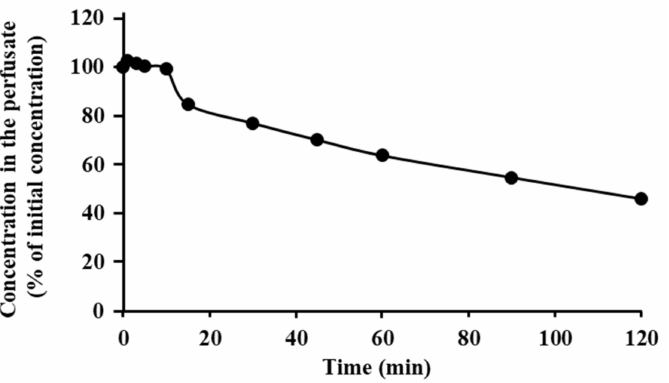
as the mean ± SE of three experiments.